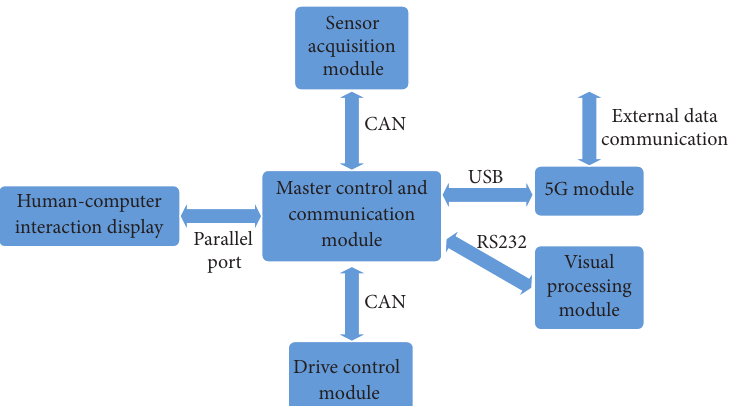
Figure 10: Control module of intelligent safety monitoring robot for shaft